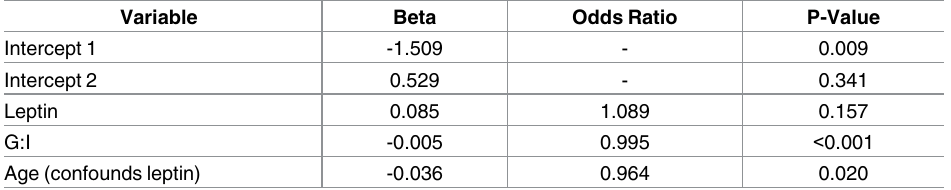
Table 9. Leptin and the glucose-to-insulin ratio (G:I) in predicting body condition using multinomial logistic regression.